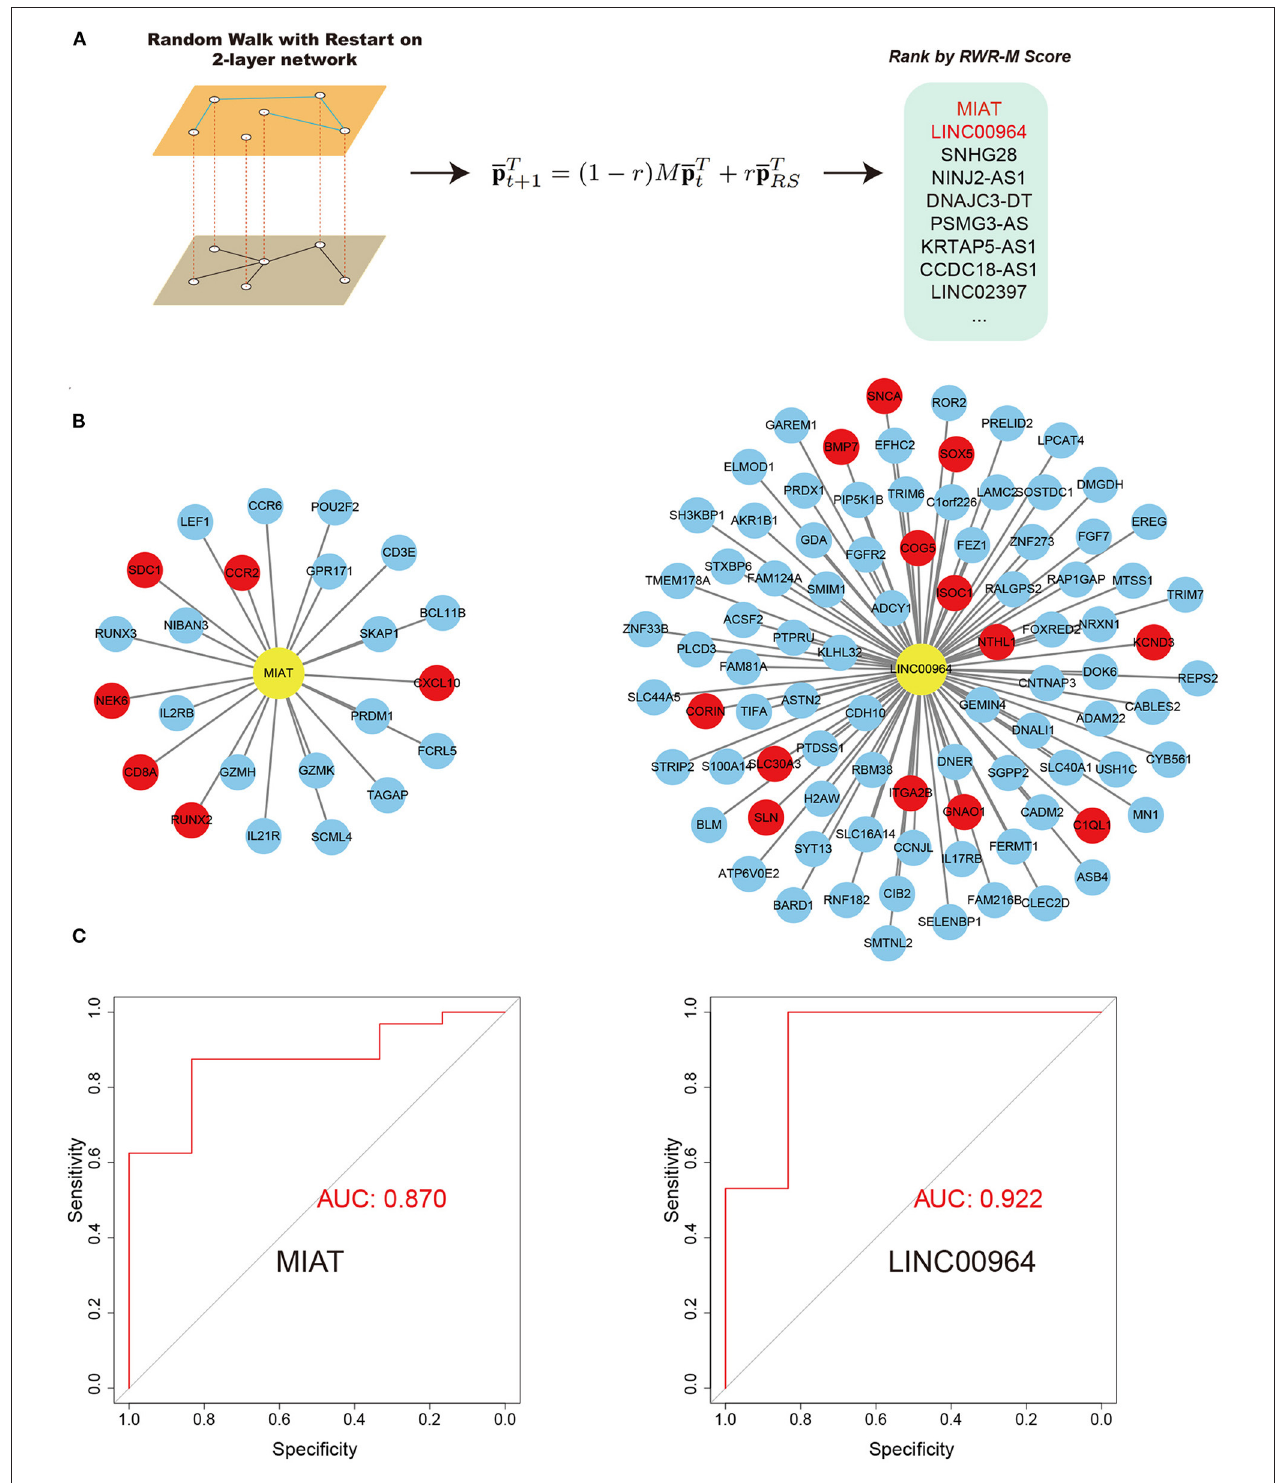
FIGURE 5 | RWR-M algorithm and the performance of random forest classifiers in the test set. (A) Process of RWR-M. (B) MIAT-related ceRNA pairs (left) and LINC00964-related ceRNA pairs (right). Yellow color represents lncRNAs and red color represents known AF protein-coding genes. (C) Performance of the MIAT-related ceRNA pairs-based classifier (left) and the LINC00964-related ceRNA pairs-based classifier (right), as reflected by their respective receiver operating characteristic curves.